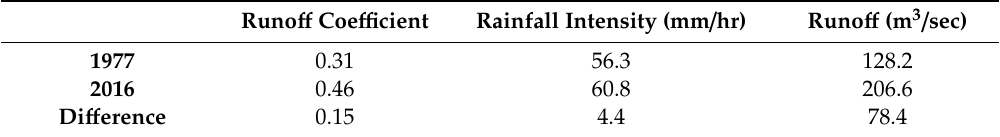
Table 5. Runo ff coe ffi cient, rainfall intensity, and runo ff of sub-watershed areas in the study area. Runo ff Coe ffi cient Rainfall Intensity (mm / hr) Runo ff (m 3 /